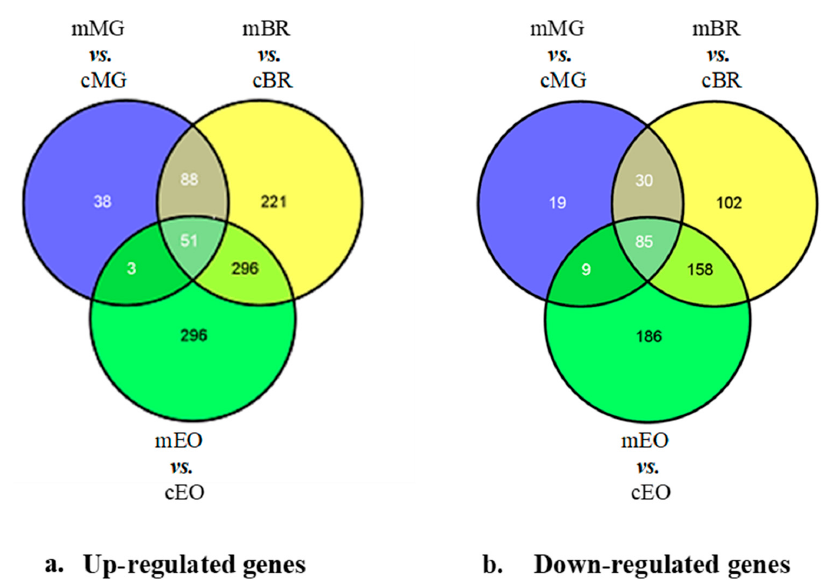
Figure 4. Venn diagram for 1-MCP treated vs. untreated tomato genes of the same ripening stage. ( a ) upregulated genes; ( b ) downregulated genes. The diagrams show the numbers of overlapping and non-overlapping genes differentially expressed. Each panel describes significantly up or down regulated transcripts as indicated (panel a ≥ 2 fold change, panel b ≤ 2 fold change), (adjusted p < 0.05). c—Control (untreated), m-1—MCP treated, MG—mature green, BR—breaker, EO—early orange. was greater at the transition from MG to BR than from BR to EO (Figure 5). This indicates a high responsiveness of the fruit to 1-MCP from MG to BR, which became much less from BR to EO.